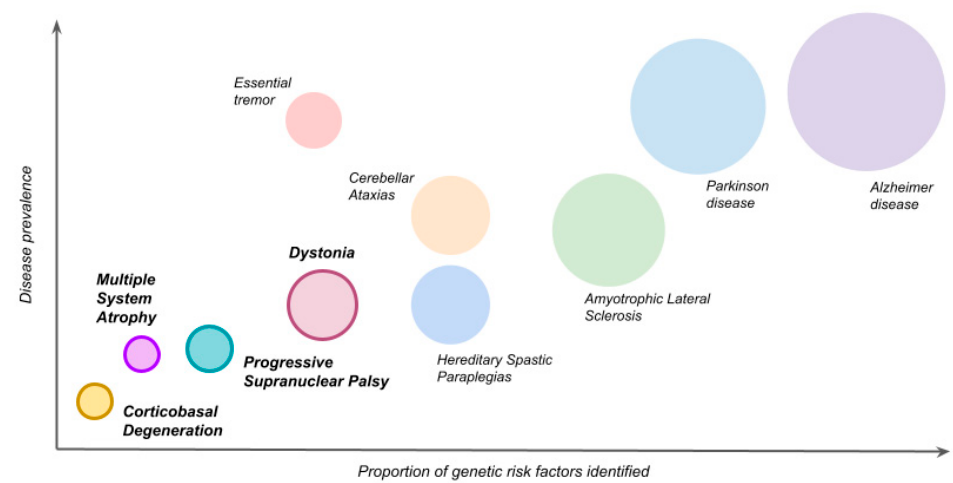
Figure 1. The genetic landscape of movement and neurodegenerative disorders. The diameters of each circumference approximate their relative frequency (greater diameter, greater prevalence).